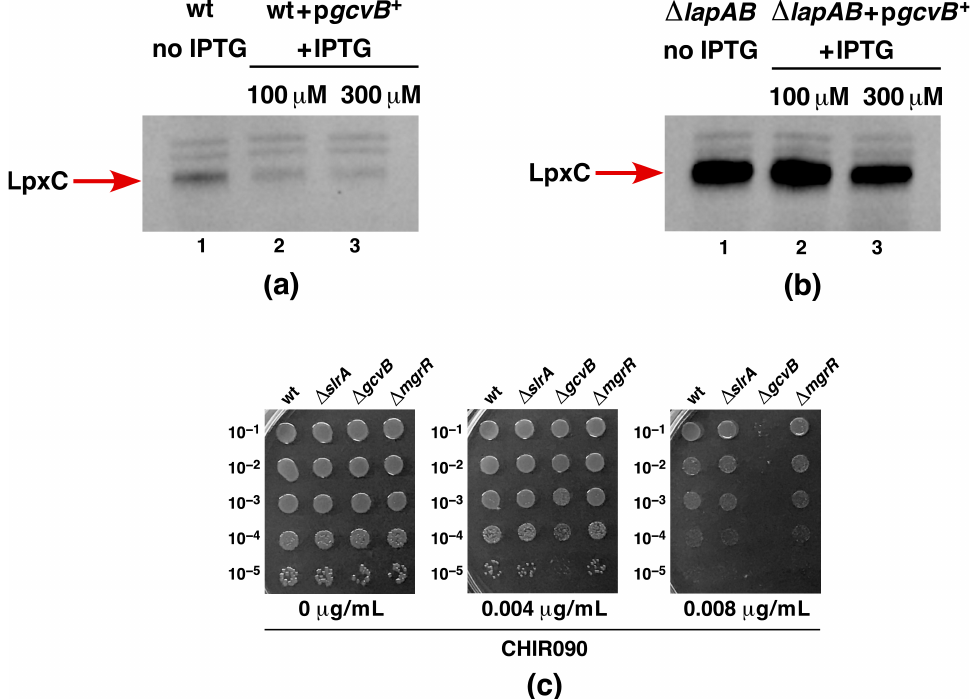
Figure 15. Overexpression of the gcvB sRNA represses LpxC accumulation in the wild type. ( a ) Equivalent amounts of total cellular proteins were applied from the isogenic strain’s wild type with the vector alone (lane 1) and when the expression of gcvB was induced upon the addition of 100 and 300 µ M IPTG (lanes 2 and 3, respectively). Proteins were resolved on a 12.5% SDS–PAGE and immunoblotted with anti-LpxC polyclonal antibodies. ( b ) Immunoblot analysis of the total cellular extracts obtained from ∆ lapAB with the vector alone without the addition of IPTG (lane 1) and from ∆ lapAB transformed with the plasmid with the inducible expression of gcvB sRNA (lanes 2 and 3) with the addition of the indicated amounts of IPTG. Cultures of ∆ lapAB were grown in M9 minimal medium up to an OD 595 of 0.2 prior to the addition of IPTG, and allowed to grow for another 2 h. Equivalent amounts of proteins were resolved on a 12.5% SDS–PAGE and transferred using Western blotting. The immunoblots were treated with anti-LpxC polyclonal antibodies in order to detect LpxC. The arrow indicates the position of LpxC. ( c ) Exponentially grown cultures of the wild type and its deletion derivatives lacking sRNA encoding genes were serially spot diluted in LA agar, supplemented with or without varying concentrations of CHIR090, as